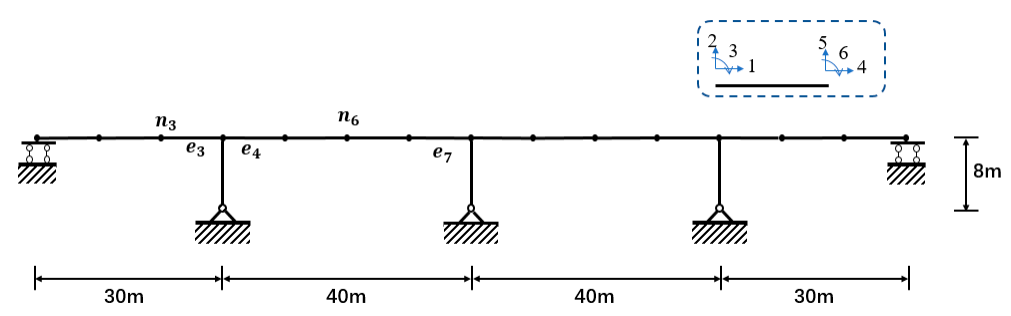
Figure 10. Simplified computational diagram of a 4-span rigid frame bridge.